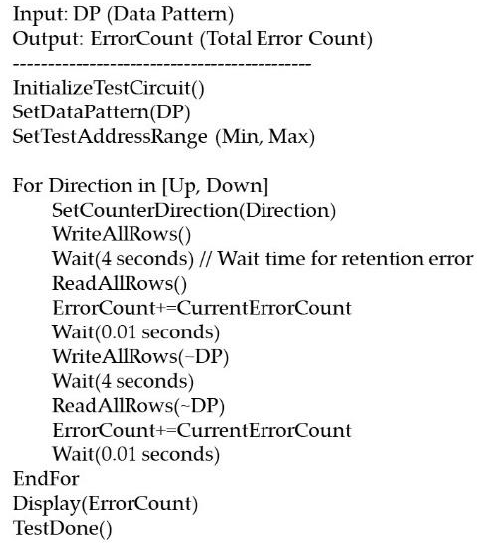
Figure 5. Retention test pseudo-code.